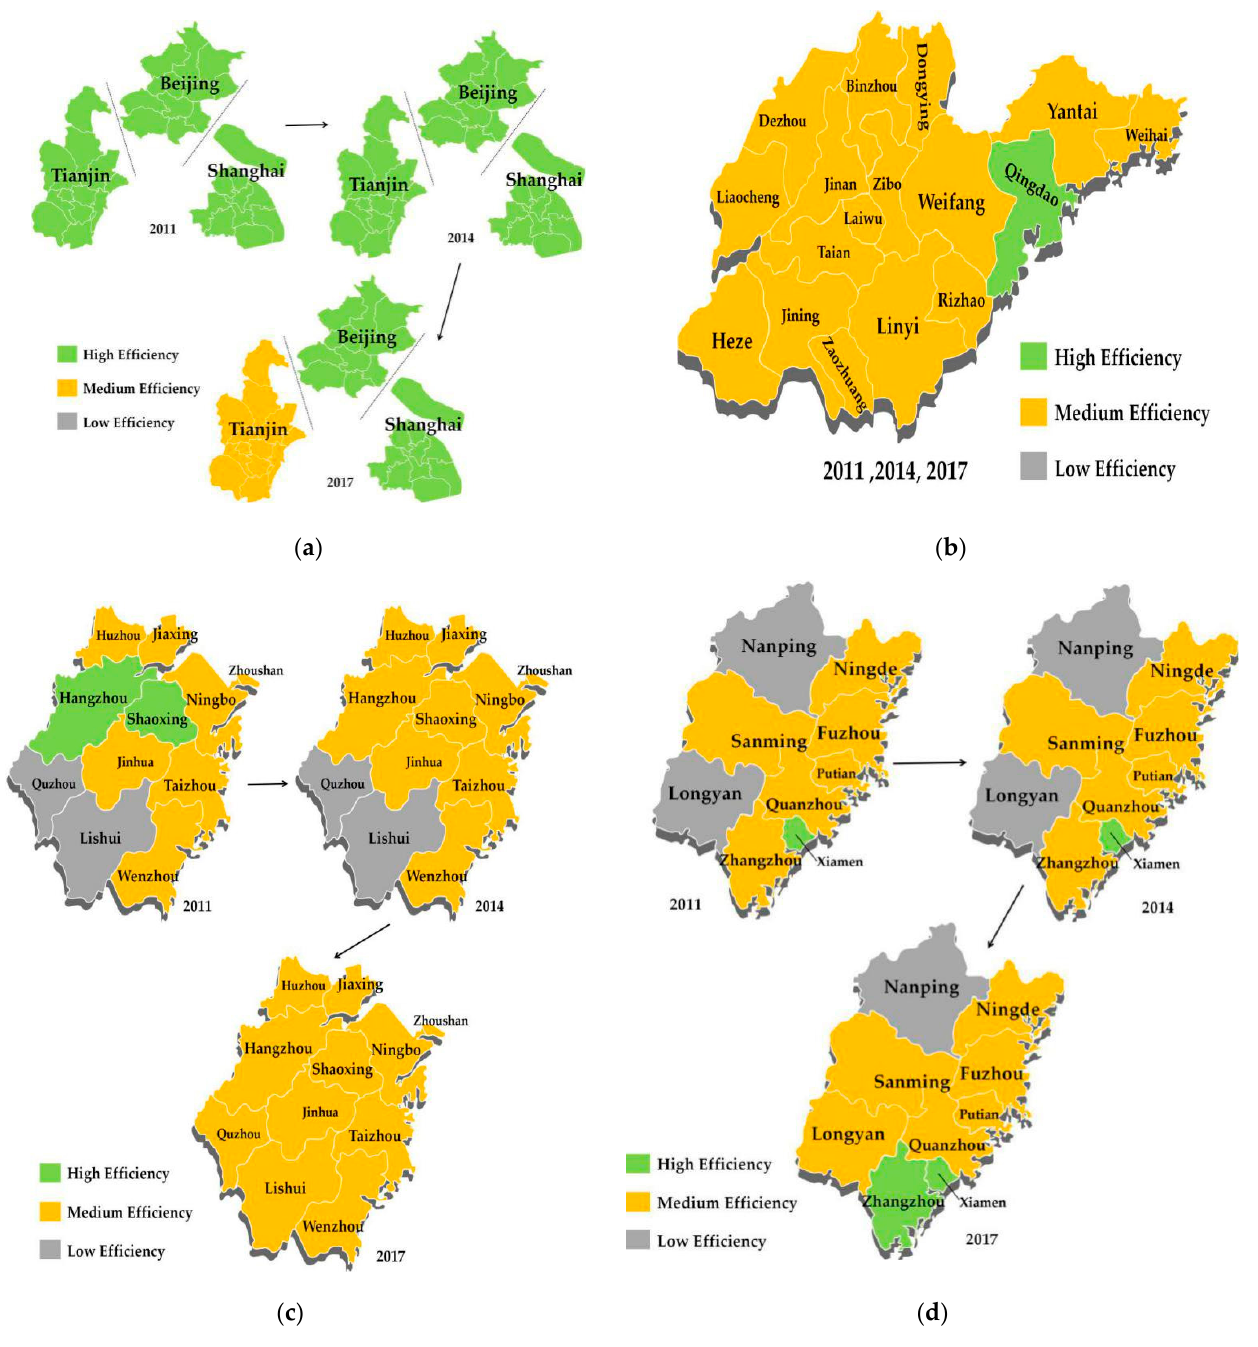
Figure 7. Spatio-temporal evolution map of land economic efficiency. ( a ) Beijing, Tianjin and Shanghai. ( b ) Shandong Province. ( c ) Zhejiang Province. ( d ) Fujian Province.